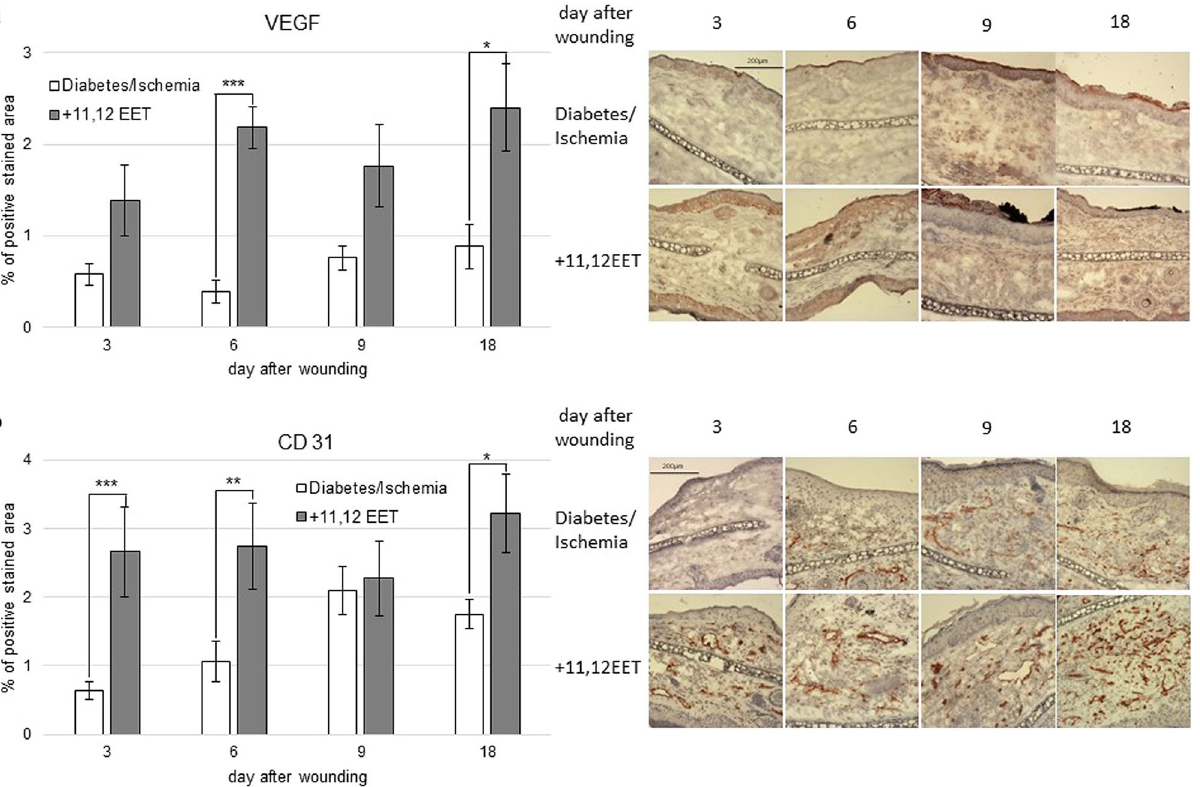
Figure 4. ( a ) Percentage of VEGF positive area on day 3, 6, 9, and 18 of ischemic wounds of diabetic mice with 11,12 EET treatment and solvent control; on the right, representative pictures of the staining. ( b ) Percentage of CD31 positive cells on day 3, 6, 9, and 18 of ischemic wounds of diabetic mice with 11,12 EET treatment and solvent control; on the right, representative pictures of the staining (data is shown as mean ± SD; n = 8 for day 3,6, an 9 n = 10 for day 18). * p < 0.05, ** p < 0.01, *** p <